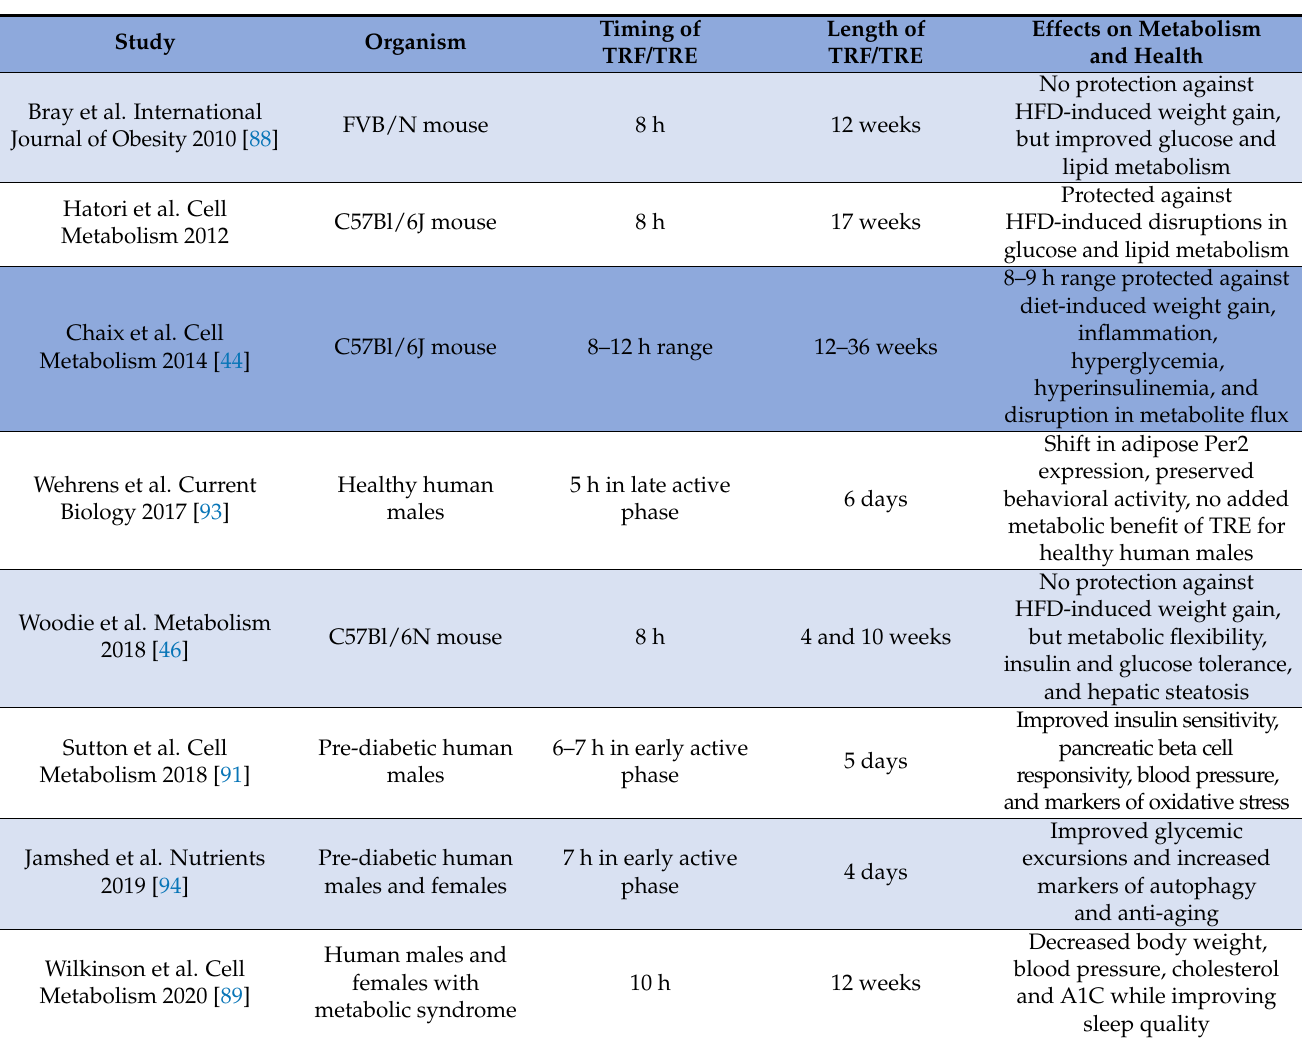
Table 1. Selected Time-Restricted Feeding/Eating Studies and their Effects on Metabolic